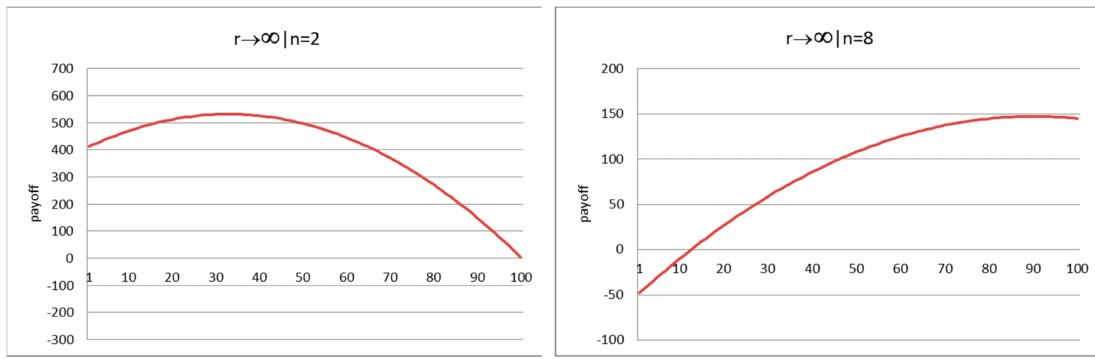
Figure 2. Empirical relationship between payoffs and